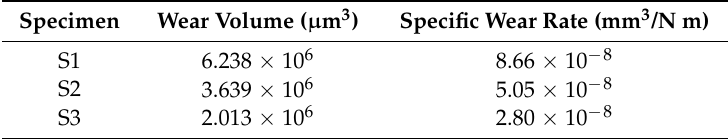
Table 4. Wear volumes and specific wear rates of coatings in a reciprocating wear condition.